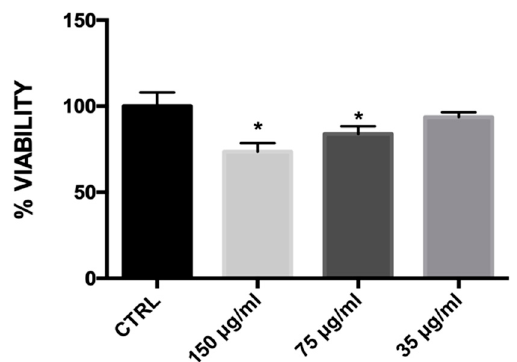
Figure 2. The viability assay in 3T3-L1 cells measured by bromide 3-(4,5-dimethylthiazol-2-yl)-2,5-diphenyltetrazolium (MTT) assay. Bars represent the mean ± SEM of six independent experiments. * p < 0.05 versus control (CTRL) cells.